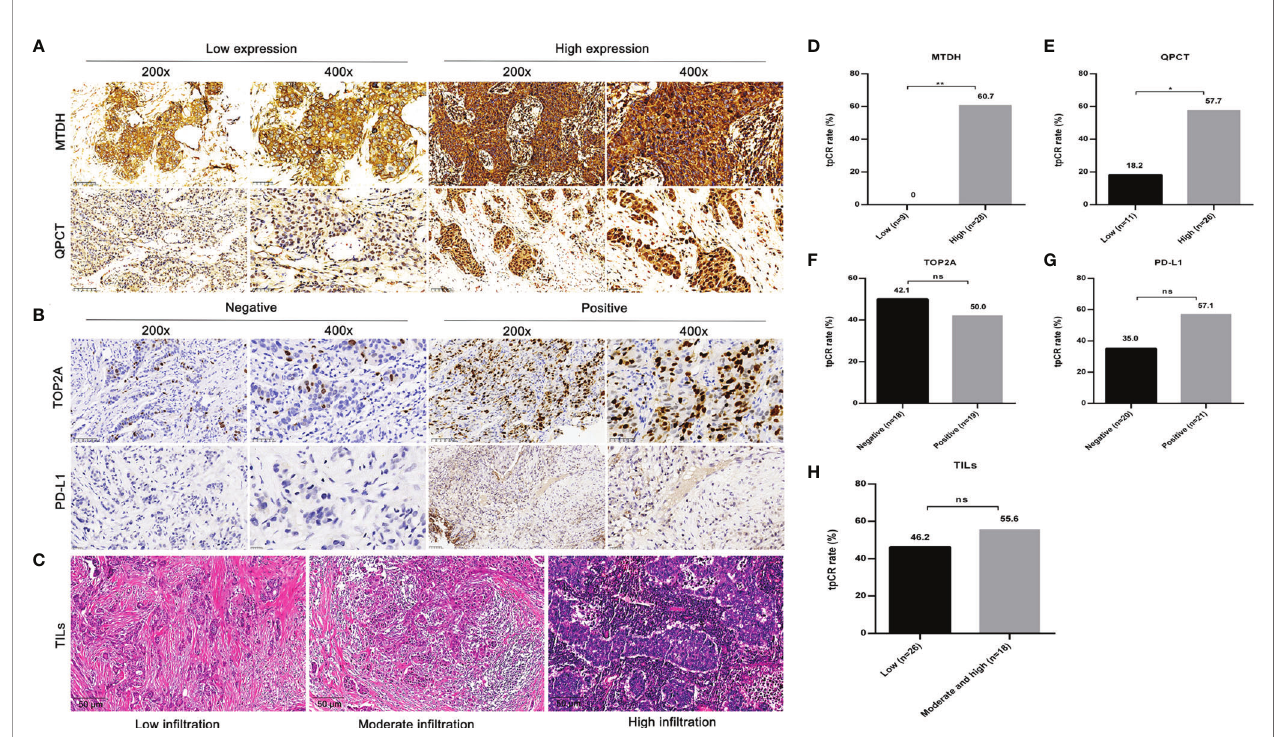
FIGURE 2 | The representative images and effect of MTDH, QPCT, TOP2A, and PD-L1 expressions, as well as in fi ltration status of TILs on tpCR. (A) Representative IHC images of MTDH and QPCT (low and high expressions). (B) Representative IHC images of TOP2A and PD-L1 (positive and negative). (C) Representative HE staining images of TILs. (D) The tpCR according to MTDH expressions. (E) The tpCR according to QPCT expressions. (F) The tpCR according to TOP2A expressions. (G) The tpCR according to PD-L1 expressions. (H) The tpCR according to in fi ltration status of TILs. tpCR, total pathological complete response; MTDH, metadherin; QPCT, glutaminyl-peptide cyclotransferase; TOP2A, topoisomerase II alpha; PD-L1, programmed death ligand 1; TILs, tumor-in fi ltrating lymphocytes; IHC, immunohistochemistry; HE, hematoxylin – eosin. * p < 0.05; ** p < 0.01.; ns, no signi fi